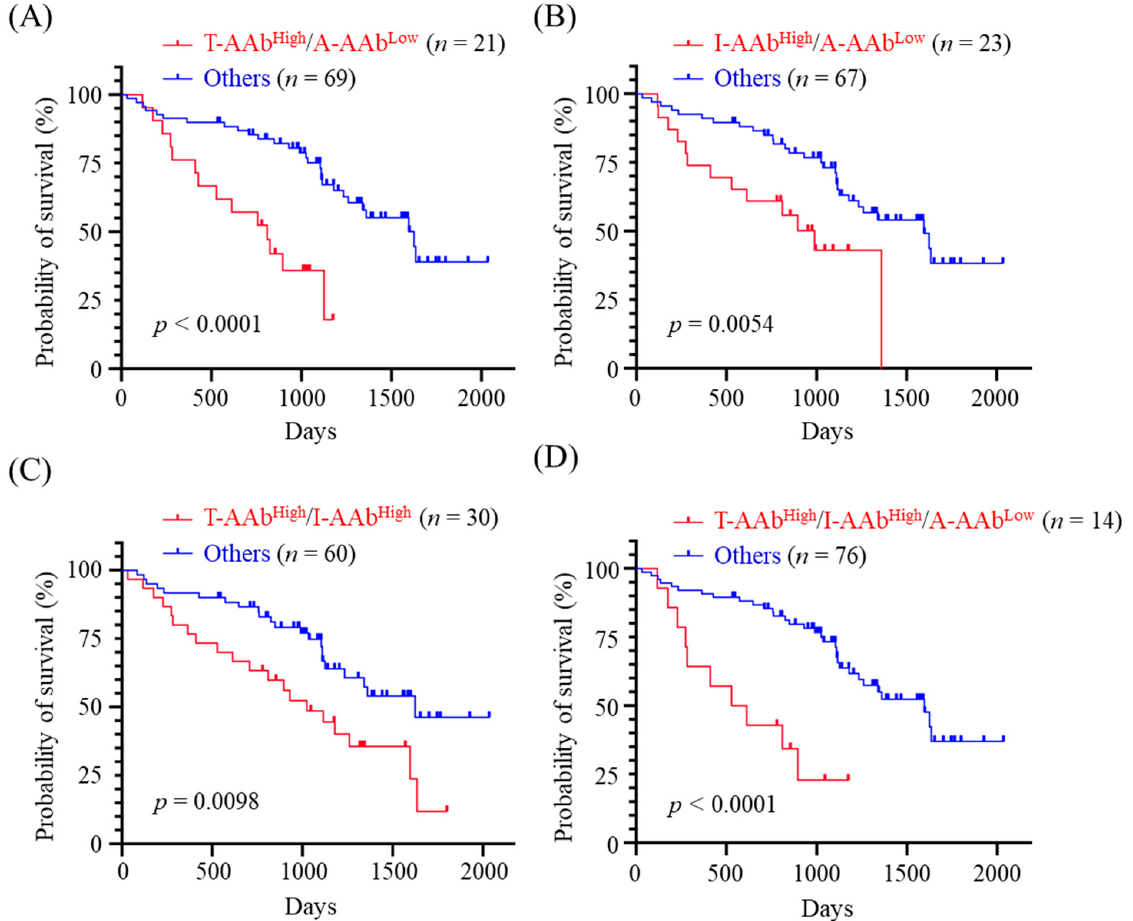
Figure 4. Correlation between the combined panels of serum AAb levels and OST of CMT dogs. CMT dogs ( n = 90) were dichotomized by a combination of ( A ) TYMS-AAb High and AGR2-AAb Low (denoted T-AAb High /A-AAb Low ), ( B ) IGFBP5-AAb High and AGR2-AAb Low (denoted I-AAb High /A-AAb Low ), ( C ) TYMS-AAb High and IGFBP5-AAb High groups (denoted T-AAb High /I-AAb Low ), and ( D ) TYMS-AAb High , IGFBP5-AAb High , and AGR2-AAb Low (denoted T-AAb High /I-AAb High /A-AAb Low ), respectively. OST of CMT dogs was compared between the dichotomous groups by using Kaplan-Meier analysis. Statistical significance was determined by the log-ranked test.